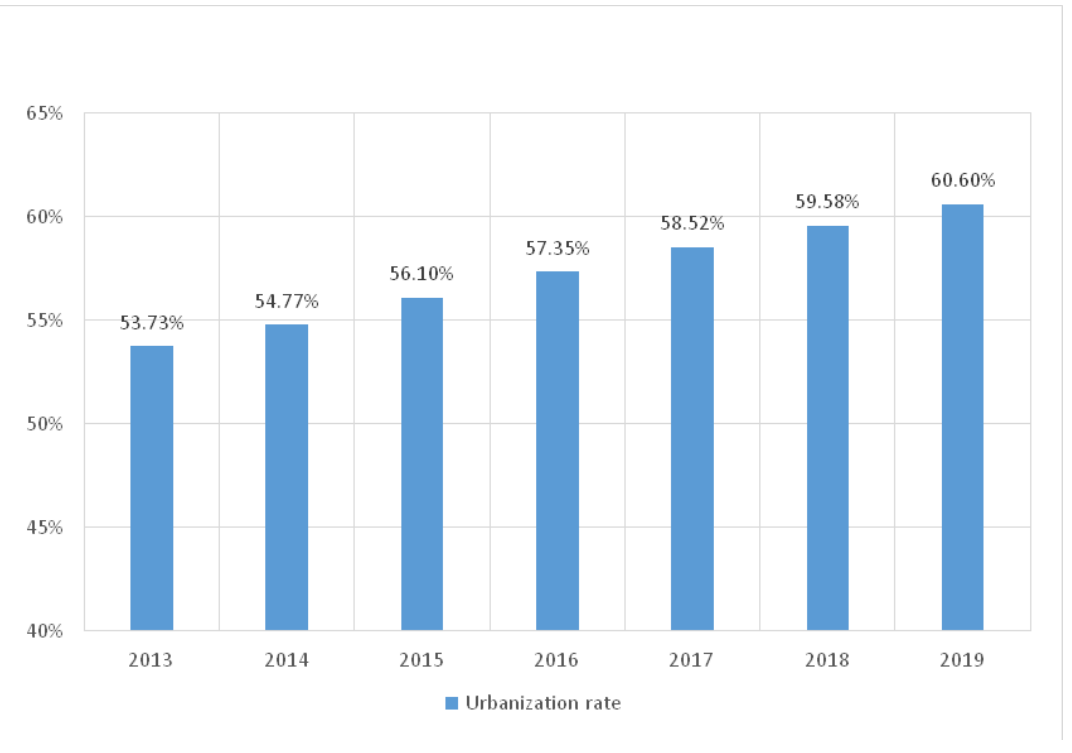
Figure 2. Annual urbanization rate in China (2013 – 2019). Data Source: National Statistics